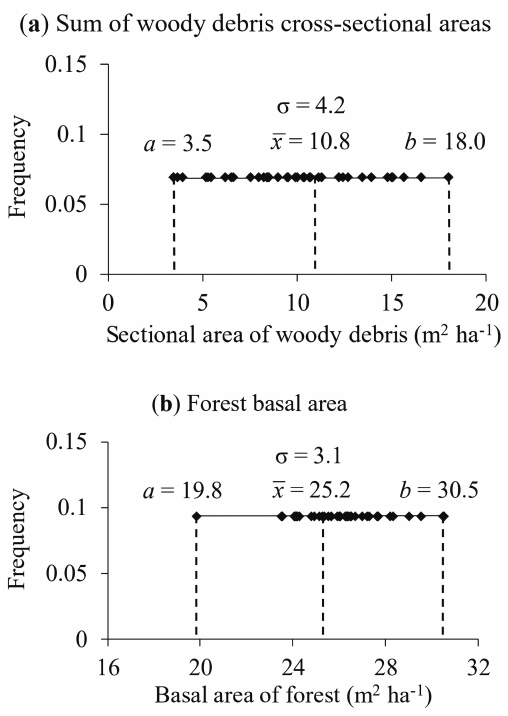
Figure 4 - Continuous rectangular distributions of the sum of woody debris cross-sectional areas ( a ) and forest basal area ( b ) in an urban mixed tropical